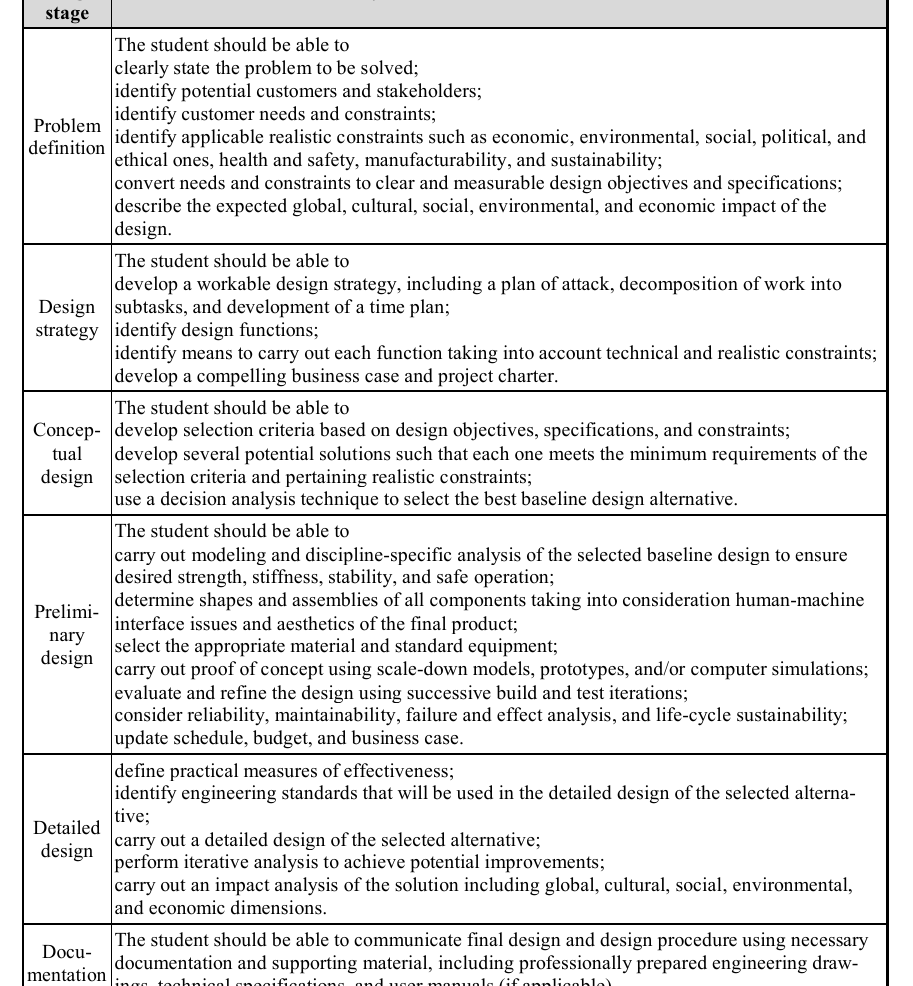
Table 2. KPIs for ABET outcome